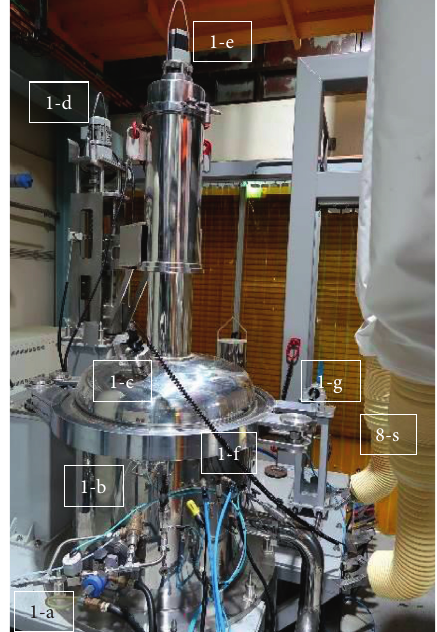
Figure 3: Subcomponents of induction-casting furnace.